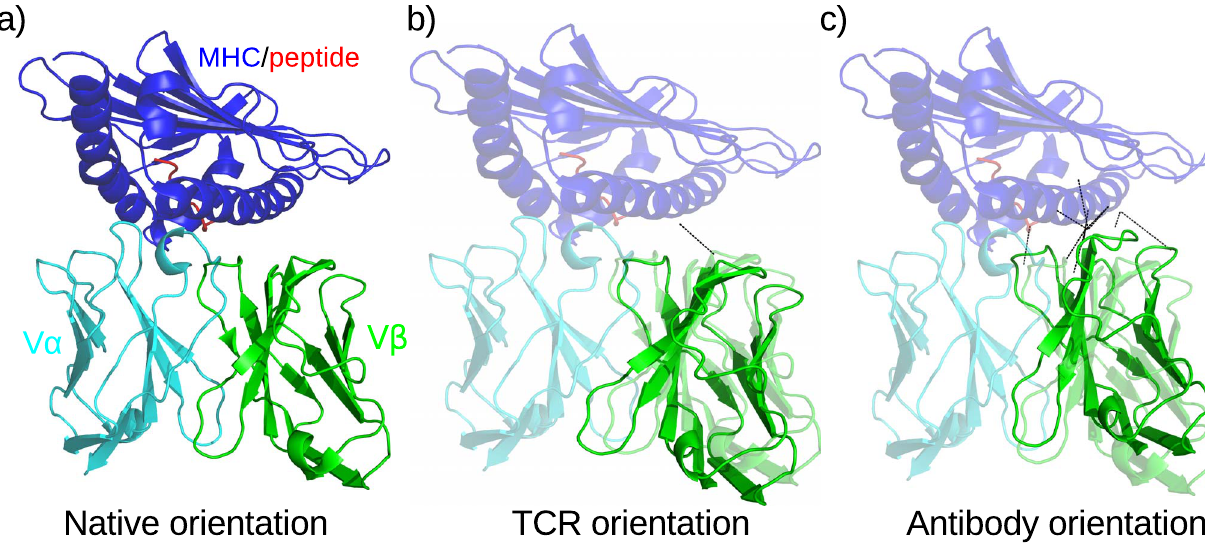
Figure 1. Changing the V b -V a orientation of a TCR/MHC-peptide complex. a) The native complex 1mi5. No residue clashes are observed between the TCR and the MHC-peptide. b) The complex with the TCR placed in the V b -V a orientation of another TCR structure. A single clash (black line) is identified between the V b domain and the MHC. c) The complex with the TCR placed in the VH-VL orientation of an antibody. Multiple residue clashes, shown by black lines, are found between the V b domain and the MHC.